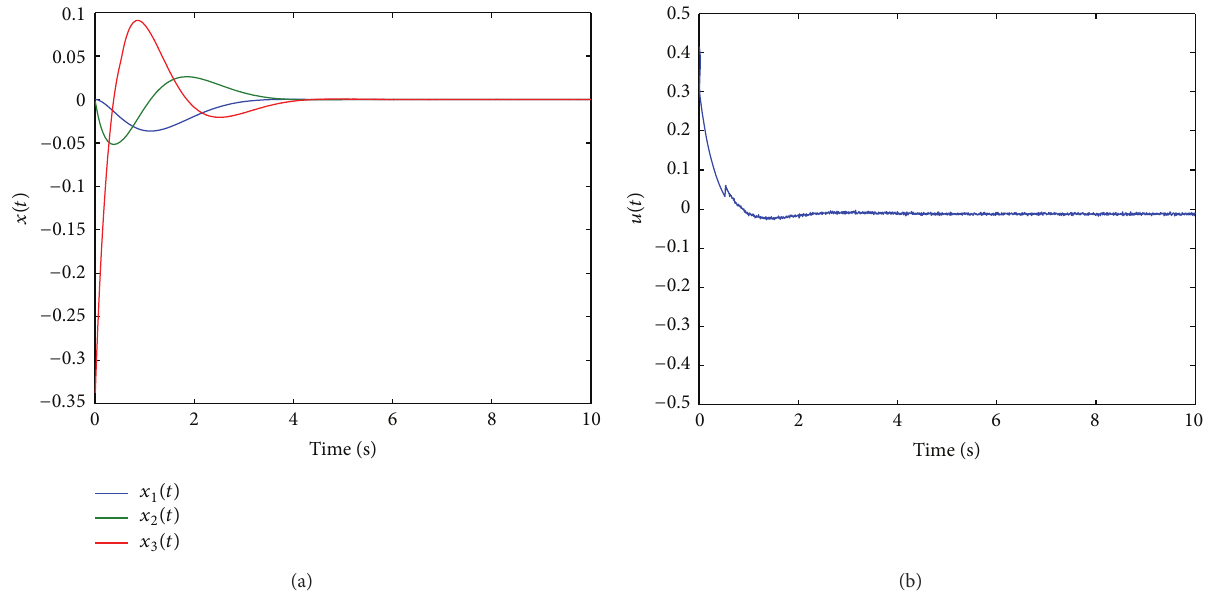
Figure 5: (a) States responses with TPAISMC ( 𝜎 -adaptation). (b) Control input with TPAISMC ( 𝜎 -adaptation).